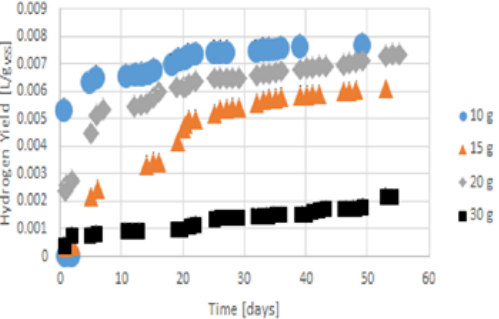
Figure 7. Accumulated hydrogen yield from gelatine during 55 days for concentrations from 10 g VSS/L to 30 g VSS/L.